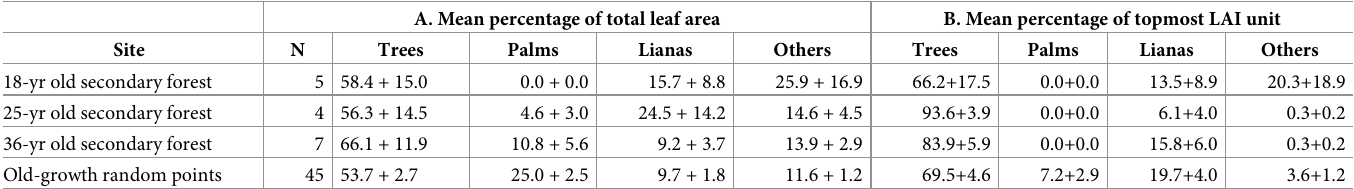
Table 3. A. The relative contributions of major plant functional groups to leaf area (% + 1 SEM) across a tropical rainforest successional gradient at the La Selva Biological Station, Costa Rica. The “Others” category includes herbs, epiphytes, ferns and non-woody vines. Data from old growth are from [35]. B. Mean percentage functional group composition of the first (topmost) LAI unit (+ 1 Standard Error of the